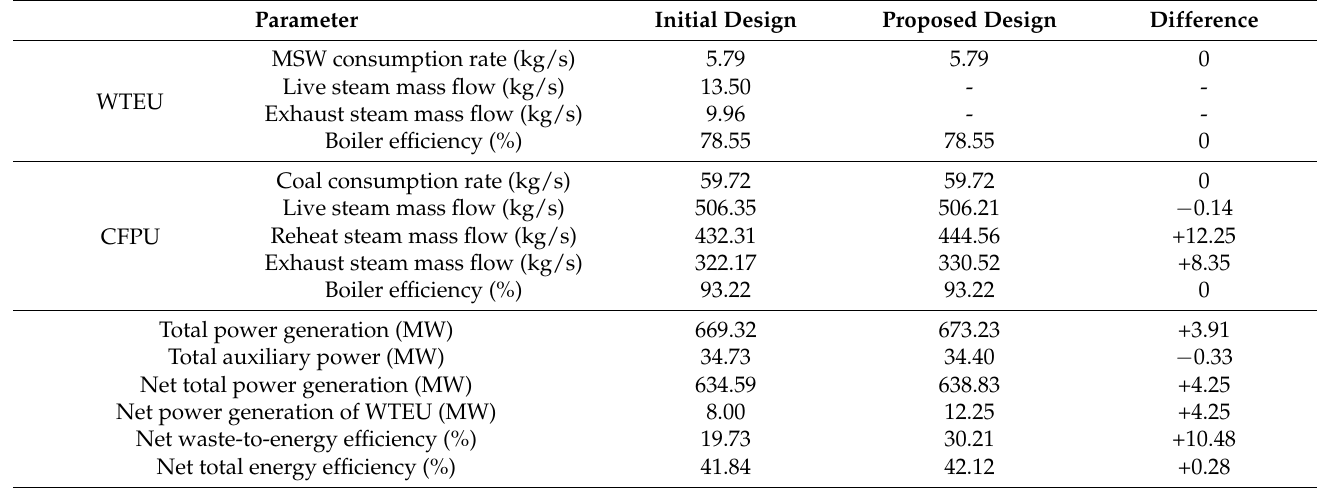
Table 14. Comparison of the energy analysis results between the initial and proposed